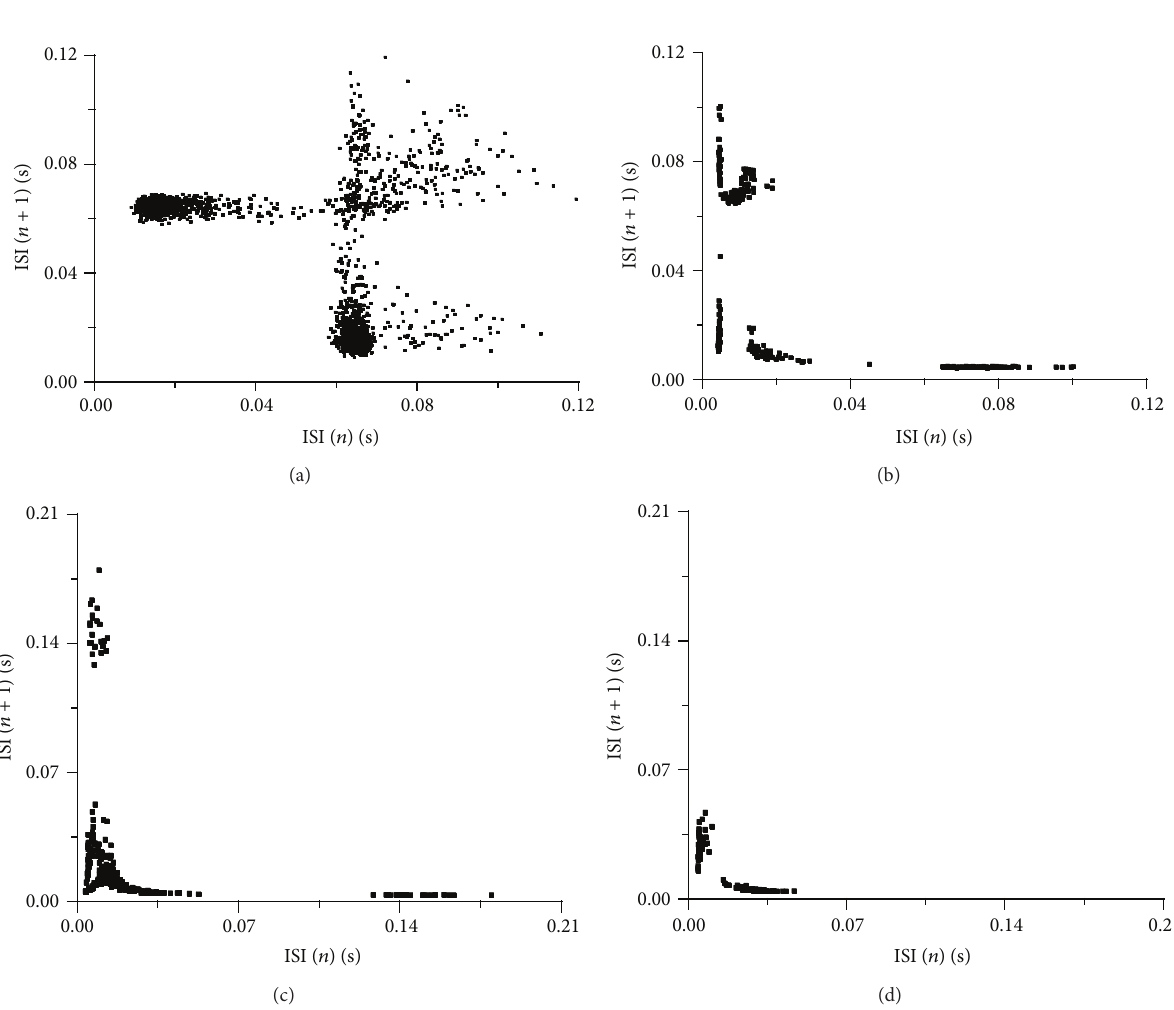
Figure 5: The first return map of ISI series of chaotic firing within the bifurcation scenario shown in Figure 4. (a) Chaotic bursting lying between period-1 and period-2 bursting patterns. (b) Chaotic bursting between period-2 and period-3 bursting patterns. (c) Chaotic bursting after period-4 bursting. (d) Chaotic